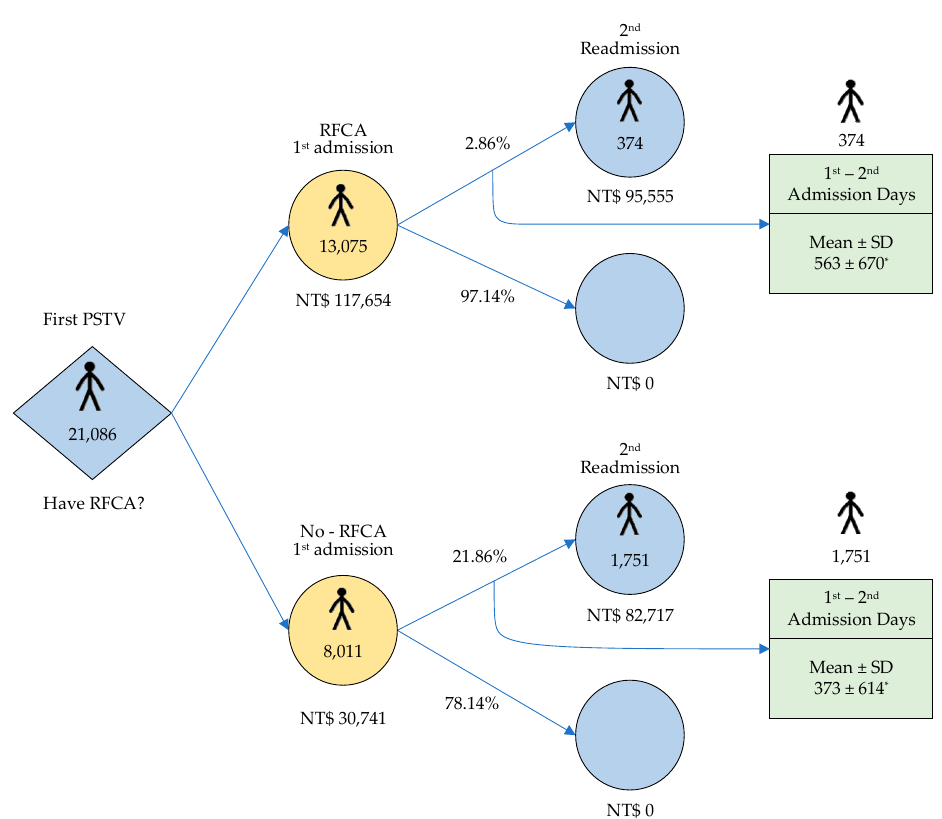
Figure 4. Cost per PSVT patient at the 1 st and 2 nd admissions with RFCA and without RFCA (* p -value < 0.0001).